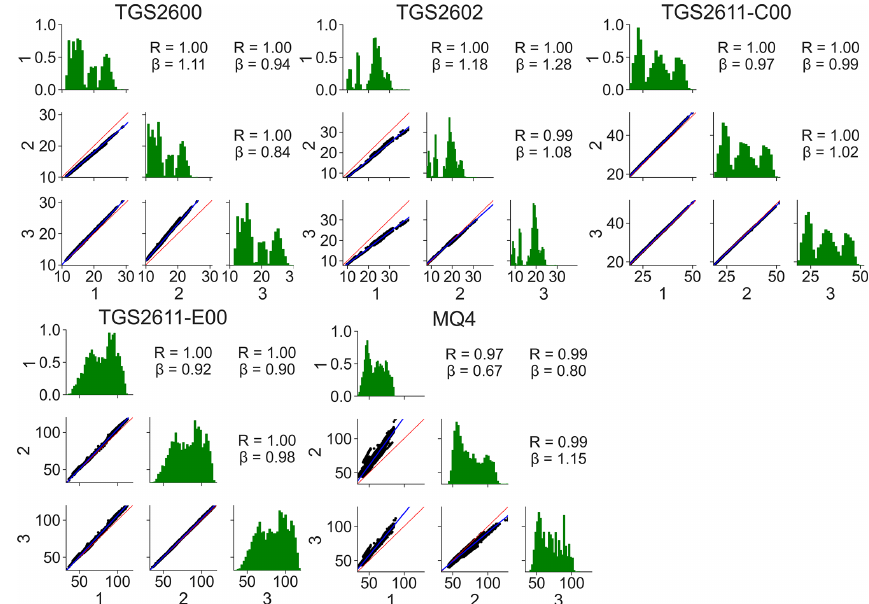
Figure 4. The experiment contained three replicates of each sensor type; each subplot shows the relationship between the three replicates of a given sensor. The lower triangles show pair plots; the upper triangles show correlation values (Pearson’s r ) and the slope β of the best-fit line for each pair; the green plots on the diagonal show distributions. The x axes for all plots and the y axes for the lower triangles are electrical resistance values in k (cid:127) .